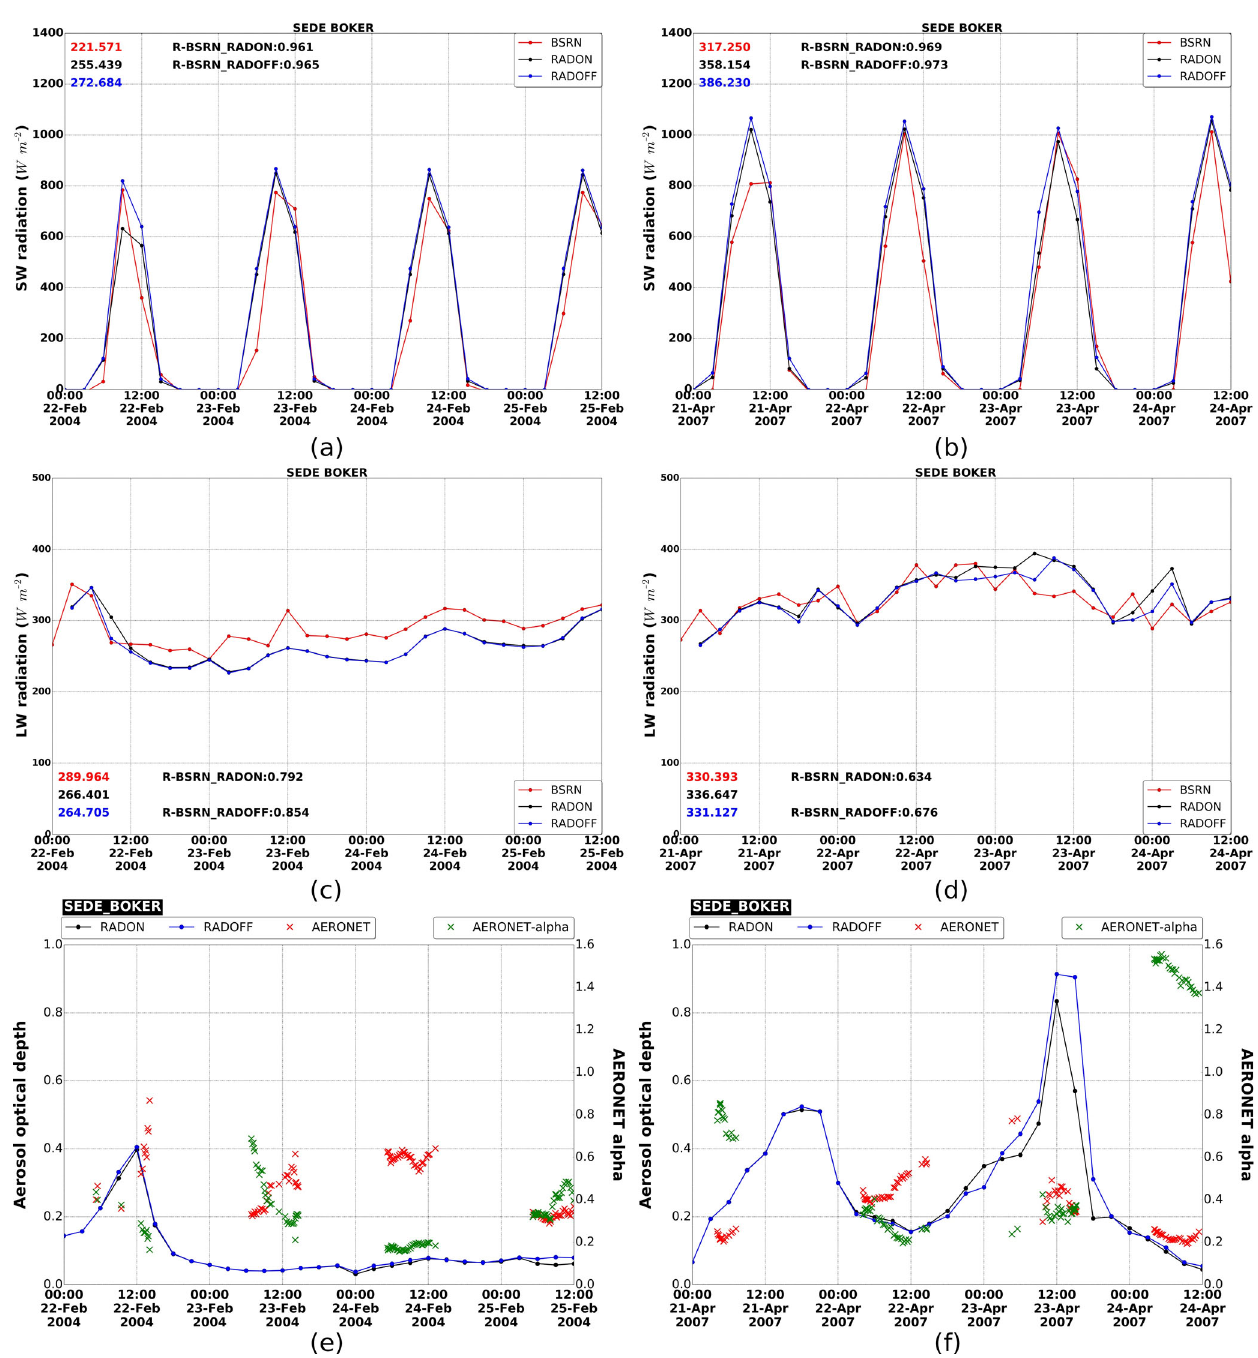
Figure 10. Time series of the downwelling: (a, b) SW and (c, d) LW radiation measured at SEDE_BOKER (red line) and simulated based on the RADON (black line) and RADOFF (blue line) configuration of the NMMB-MONARCH model during the periods: (a, c, e) 22 February 2004 at 00:00UTC–25 February 2004 at 12:00UTC and (b, d, f) 21 April 2007 at 00:00UTC–24 April 2007 at 12:00UTC. The mean ground and modelled values along with the computed correlation coefficients ( R ) between RADON-BSRN and RADOFF-BSRN, both calculated over the simulation periods, are also provided. (e, f) Time series of the simulated dust AOD at 550nm for the RADON (black line) and RADOFF (blue line) configuration of the NMMB-MONARCH model. The AERONET total AOD at 500nm (red x symbols) and AERONET alpha (green x symbols) values are